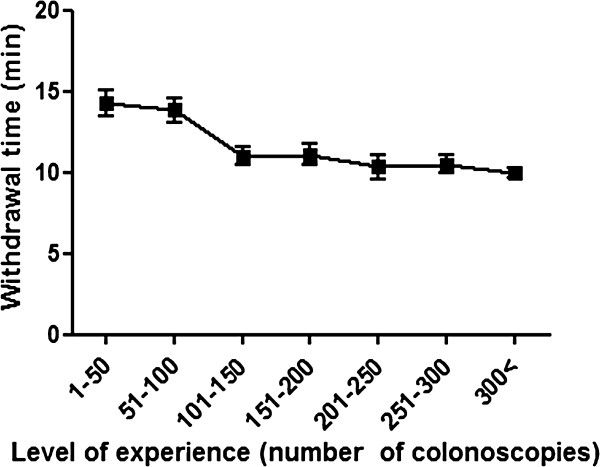
Withdrawal time learning curves. The learning curve for average withdrawal times is shown. (Error bars represent the 95% confidence interval). Withdrawal times decrease with the level of experience, but steady around 10 minutes after 150 procedures.